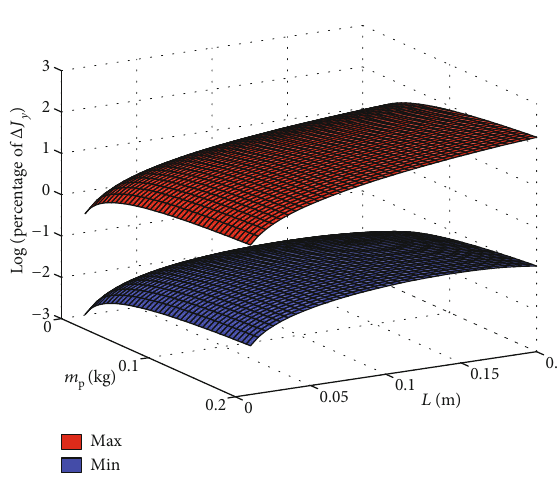
w : r : t : m and L p y